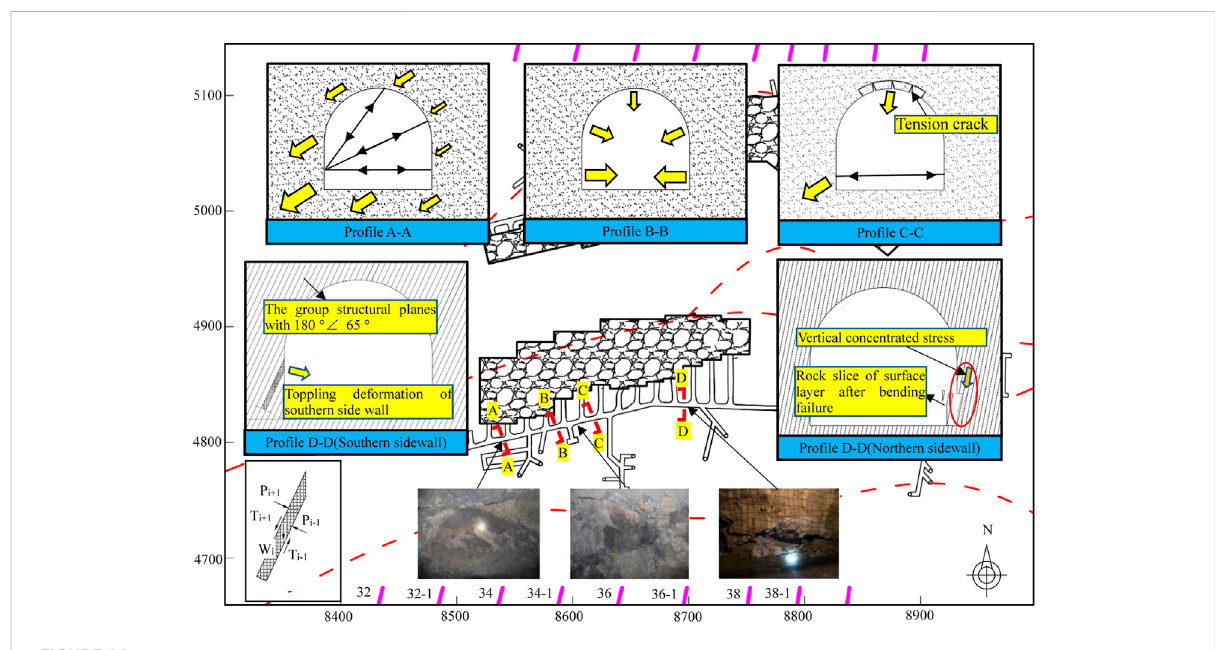
FIGURE 14 Deformation mechanism of each part of the haulage drift in hanging